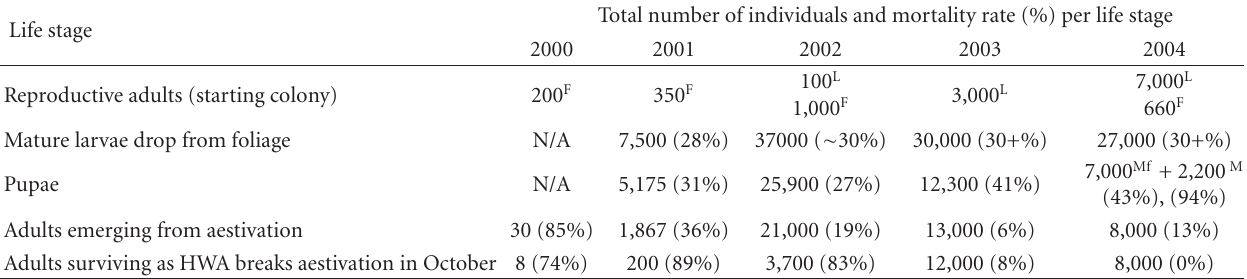
Table 1: Survival of Laricobius nigrinus (Coleoptera: Derodontidae) at di ff erent life stages from laboratory rearing e ff orts between 2000 and 2004.